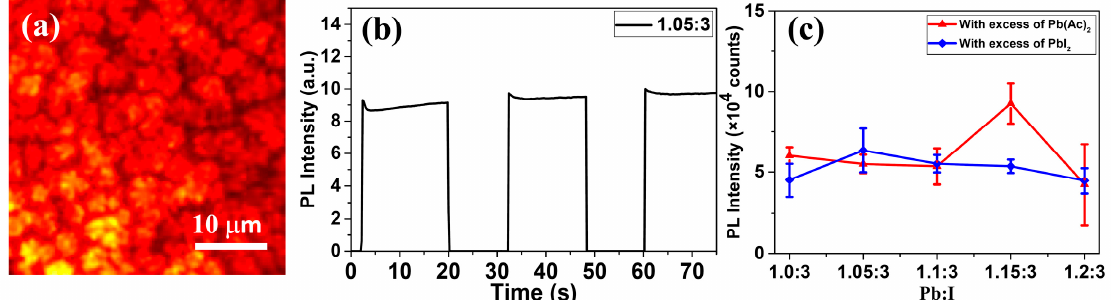
Figure 5. ( a ) PL images of Pb(Ac) 2 -excess CH 3 NH 3 PbI 3 films, ( b ) PL traces under 532 nm photo-excitation with a power density of 5 W/cm 2 , ( c ) Comparisons of the PL intensity between PbI 2 -excess and Pb(Ac) 2 -excess films.